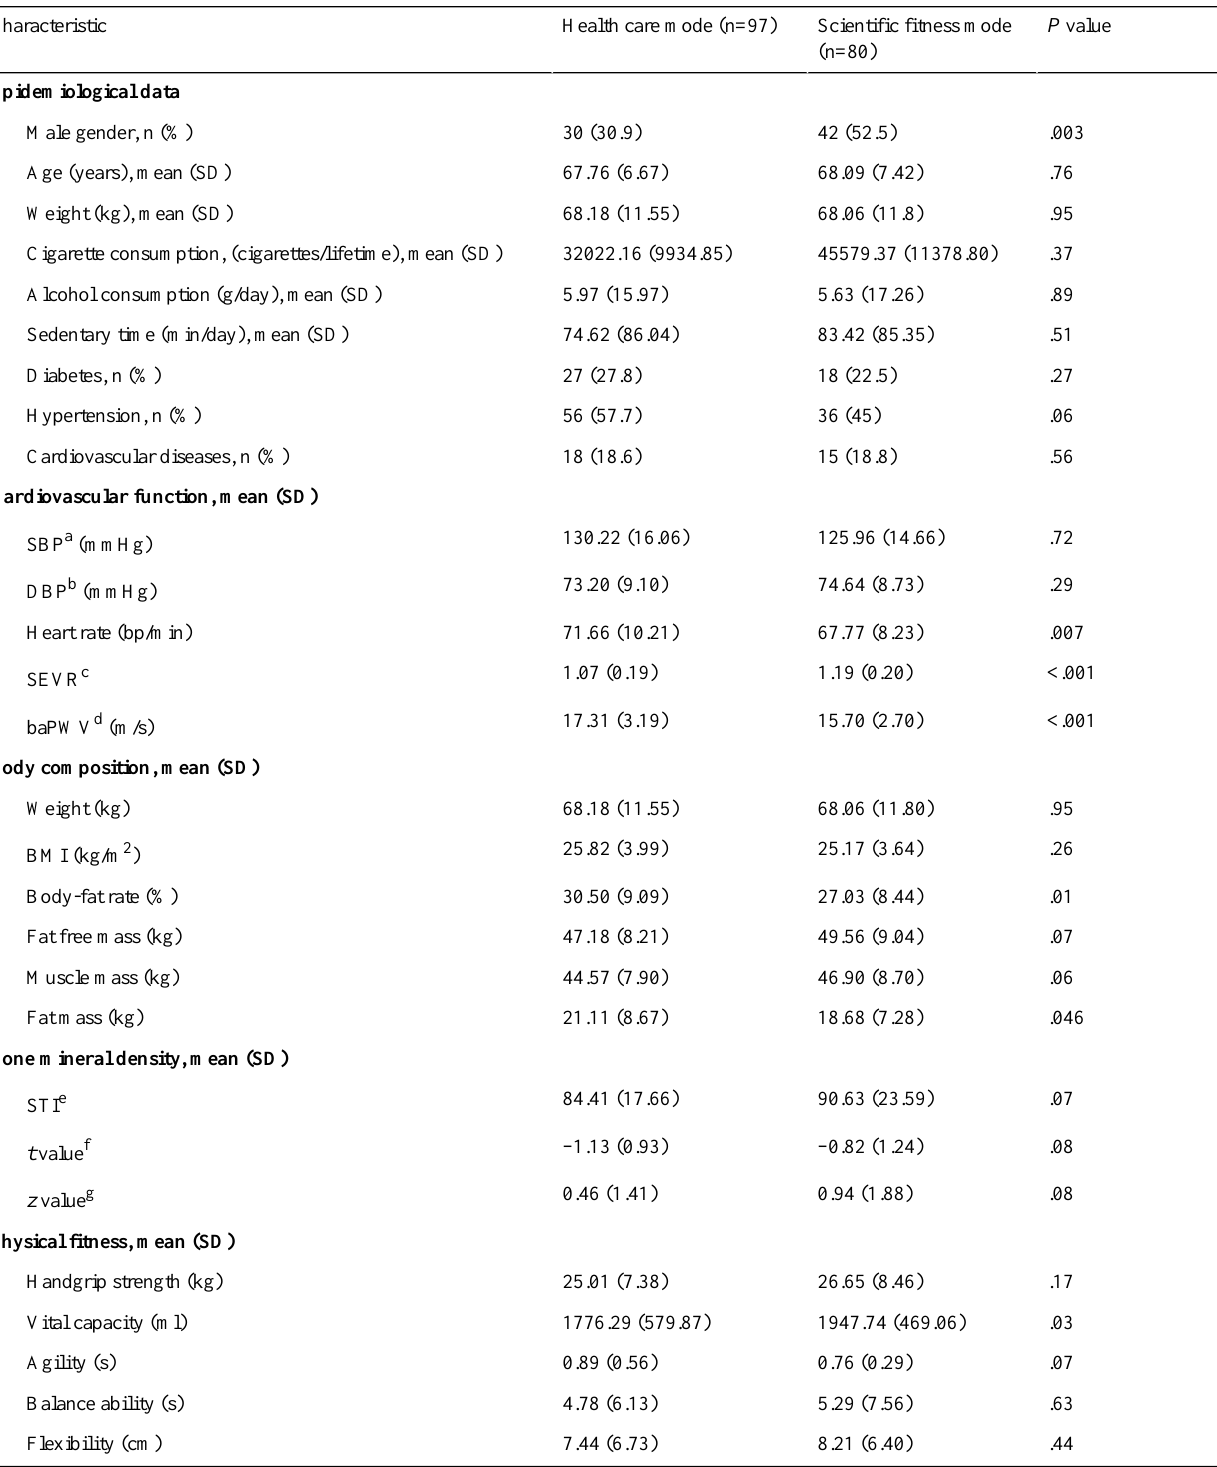
P valueScientific fitness mode (n=80)Health care mode (n=97)Characteristic